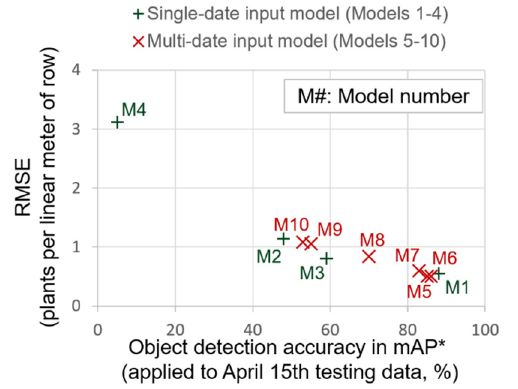
Figure 14. Relation of plant count error and object detection accuracy depending on the use of single-